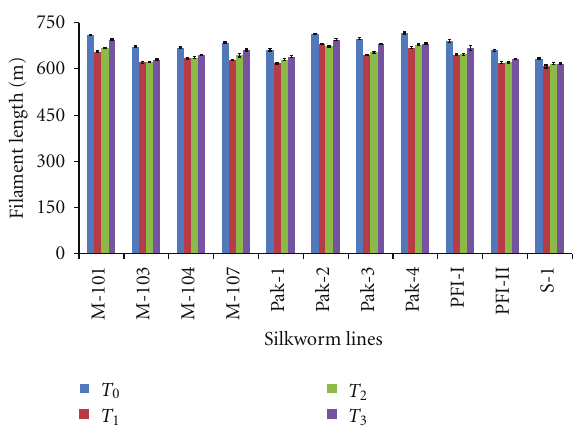
Figure 13: Comparative performance of filament length (mean ± SE) of eleven silkworm lines at 25 ± 1 ◦ C in combination with 55, 65, and 75% RH and controlled conditions of temperature and RH (25 ± 1 ◦ C and 70–80% RH, resp.).